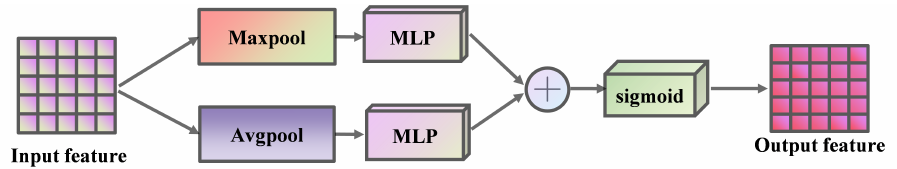
Figure 3. Structure of channel attention module.